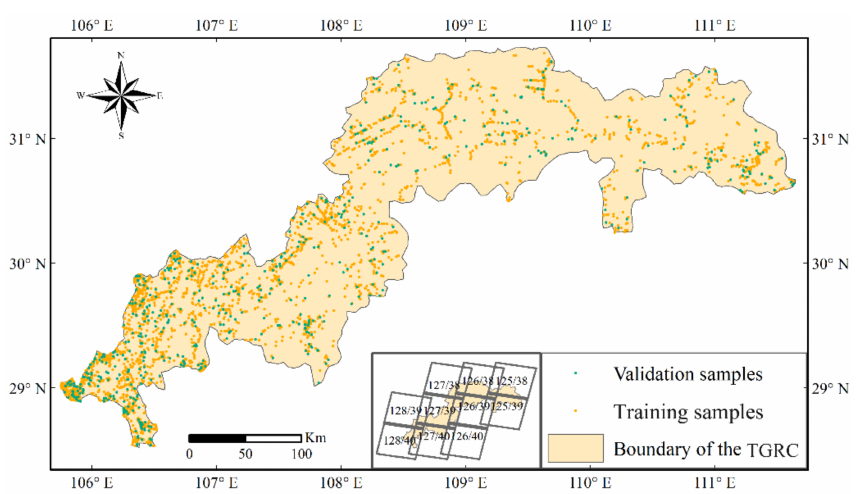
Figure 3. Training and validation sample sites in the